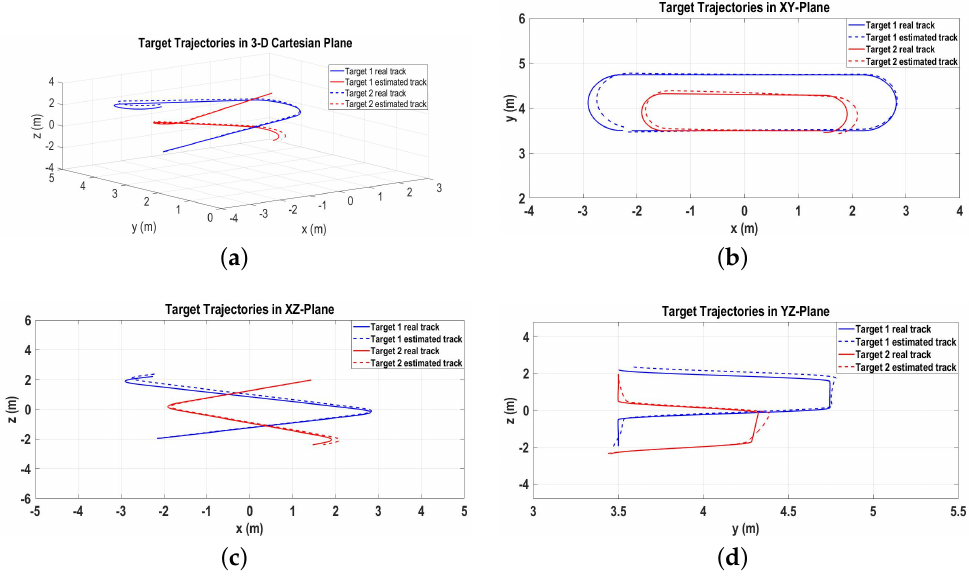
Figure 11. Real and estimated target tracks for Scenario 2. ( a ) Real and estimated target tracks in 3D Cartesian space; ( b ) Real and estimated target tracks in xy-plane; ( c ) Real and estimated target tracks in xz-plane; ( d ) Real and estimated target tracks in